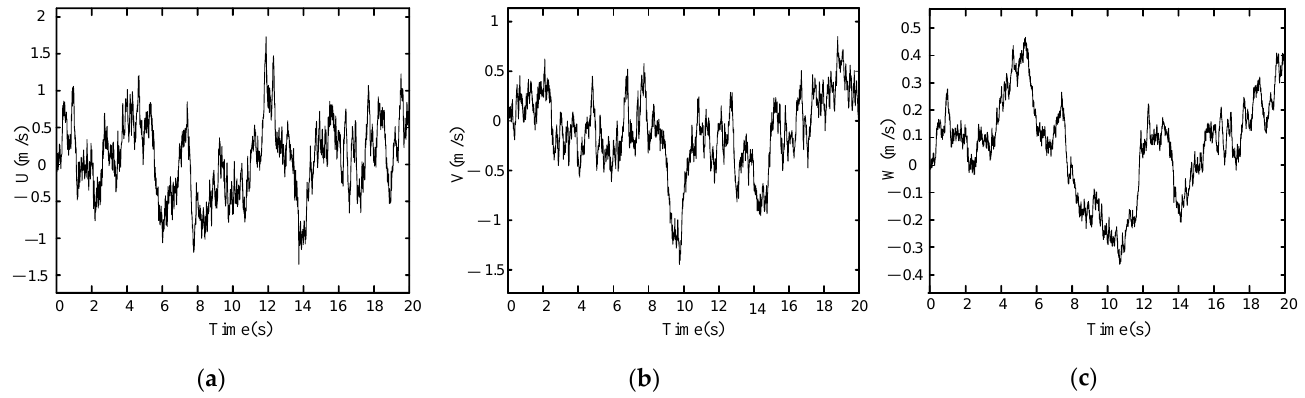
Figure 1. Free atmospheric turbulence components. ( a ) U-direction, ( b ) V-direction, and ( c ) W-direction.